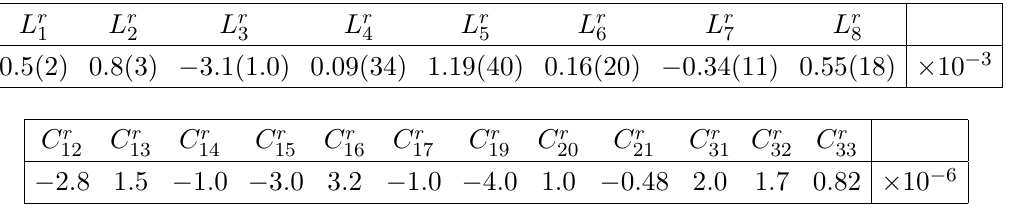
and C r at the scale (cid:22) (cid:22) = 770 MeV. i i